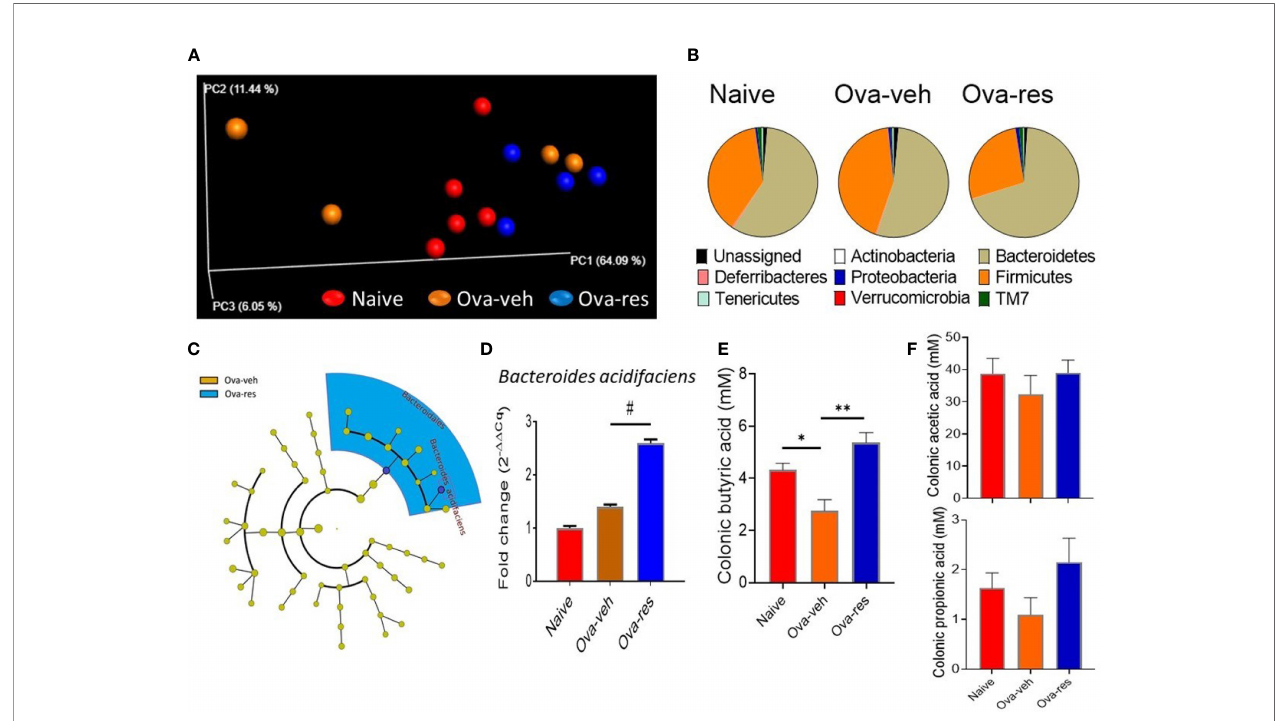
FIGURE 3 | Effect of resveratrol on gut microbiota. The gut microbiota pro fi le was conducted as described in Methods. (A) Principal coordinator analysis shows the speci fi c distribution of gut microbiota in the mice belonging to the naïve, Ova-veh and Ova-res groups. (B) Pie charts showing the percentages of common bacterial phyla in the gut microbiota among naïve, Ova-veh and Ova-res groups. (C) Cladogram showing the least signi fi cant discriminative changes of gut microbiota between Ova-veh and Ova-res group with at least 2-fold changes. (D) qPCR was used to detect the abundance of Bacteroides acidifaciens in mouse gut microbiota among naïve, Ova-veh and Ova-res groups. Mass spectrometry – gas chromatography analysis showing the differences of butyric acid (E) , and acetic acid, and propionic acids (F) concentrations in mouse colonic materials among naïve, Ova-veh and Ova-res groups. Vertical bars represent Mean+/-SEM data from groups of 5 mice. *p<0.05, **p<0.01, #